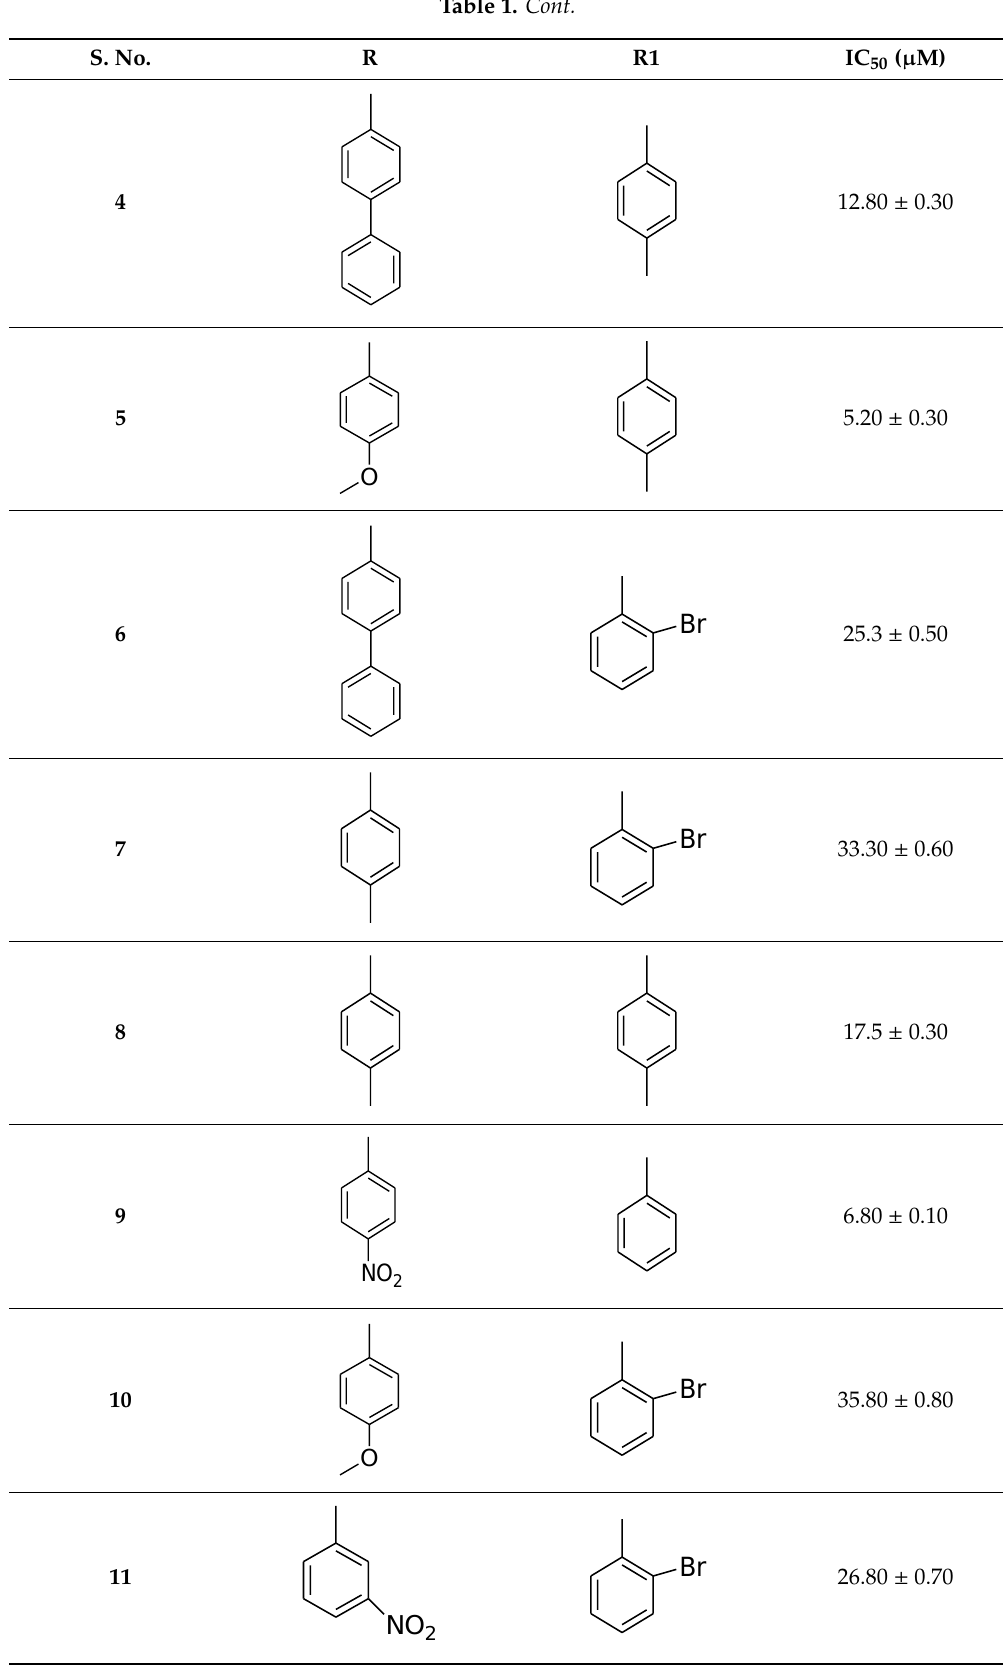
Table 1. Structure of triazinoindole-based thiosemicarbazide analogs and their α-glucosidase activity. S. No.